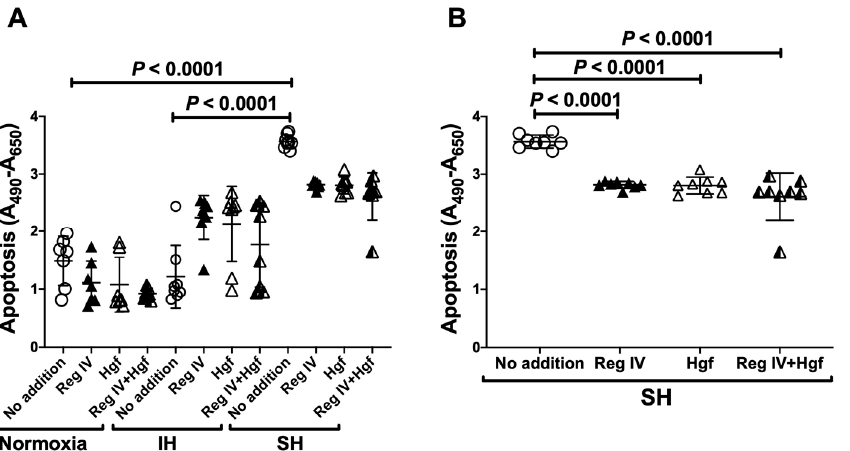
Figure 5. ( A ) Anti-apoptotic effects of Reg IV and Hgf in differentiated P19.CL6 cardiomyocytes in normoxia, IH, or SH. IH did not increase apoptosis and SH increased apoptosis ( p < 0.0001 vs. normoxia; p < 0.0001 vs. IH). ( B ) Anti-apoptotic effects of Reg IV and/or Hgf in SH. Apoptosis was quantified using the TUNEL method. Mouse recombinant Reg IV (0.1 ng/mL) and Hgf (0.1 ng/mL) were added to differentiated mouse P19.CL6 cell culture medium and incubated in normoxia, IH, or SH for 24 h. Data are expressed as mean ± SD for each group. The statistical analyses were performed